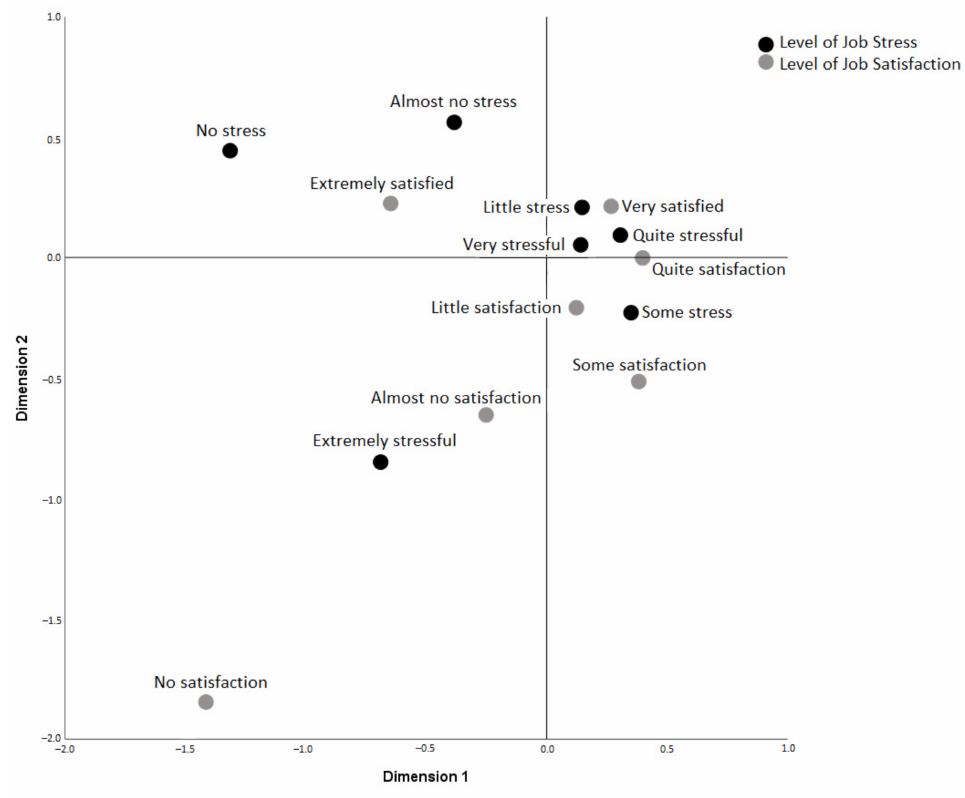
Figure 1. Simple correspondence analysis between job stress level and job